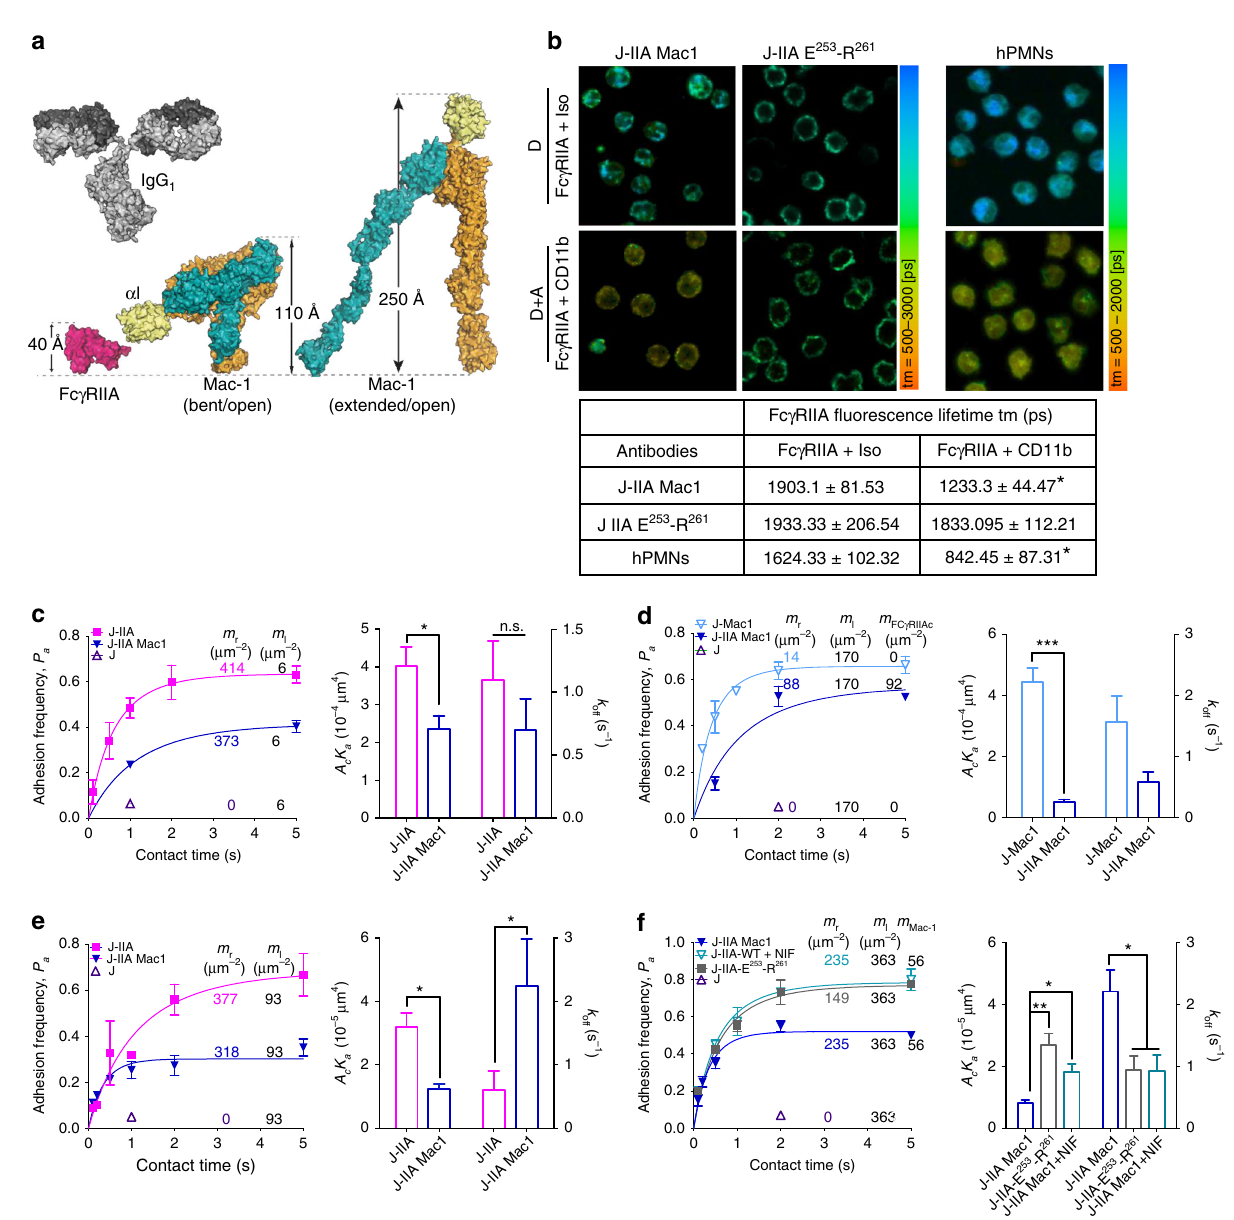
Fig. 2 Mac-1 ’ s α I domain interacts in cis with Fc γ RIIA ’ s ectodomain to lower Fc γ RIIA ’ s af fi nity for IgG. a Model of Fc γ RIIA, IgG, and Mac-1 in bent/closed and extended/open conformation based on published crystal structures. b FLIM was conducted on Jurkat cells expressing Mac-1 and Fc γ RIIA by staining with the donor (D) antibody for anti-Fc γ RIIA (IV.3 AF488) and the acceptor (A) antibody for Mac-1 (ICRF44 AF568) or an isotype control. FLIM images were taken and presented in pseudocolors from red to green. The fl uorescence lifetimes of the donor in the absence (D) or presence (A + D) of the acceptor antibody were calculated. n = 3 experiments. * p < 0.01; unpaired t -test. c – f BFP measurements of adhesion frequency-versus-contact time of the indicated Jurkat cells (J-IIA) alone or with wild-type Mac-1 (WT), or Mac-1 lacking E 253 -R 261 (E MT) with or without NIF treatment against bead immobilized Mac-1. c bead immobilized Fc γ RIIA ( d ) or bead immobilized IgG ( e , f ). The absence or presence of binding after a contact of given duration was analyzed to obtain the adhesion frequency. Bar graphs show effective 2D af fi nity (A c K a , E) and off-rate (k off , F) for each cell line. The adhesion frequencies of J-IIA-WT were lower than those of J-IIA, J-IIA-E MT, and NIF treatment of J-IIA-WT increased the effective Fc γ RIIA 2D af fi nity. Data is average ± SD. * p < 0.05, ** p < 0.01, *** p < 0.001, by unpaired, two-tailed Student ’ s t